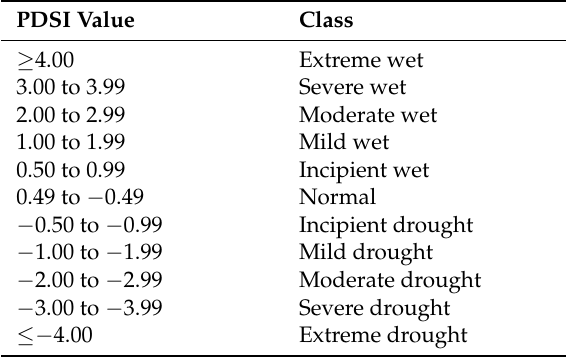
Table 2. Classification of the Palmer drought severity index (PDSI) values.